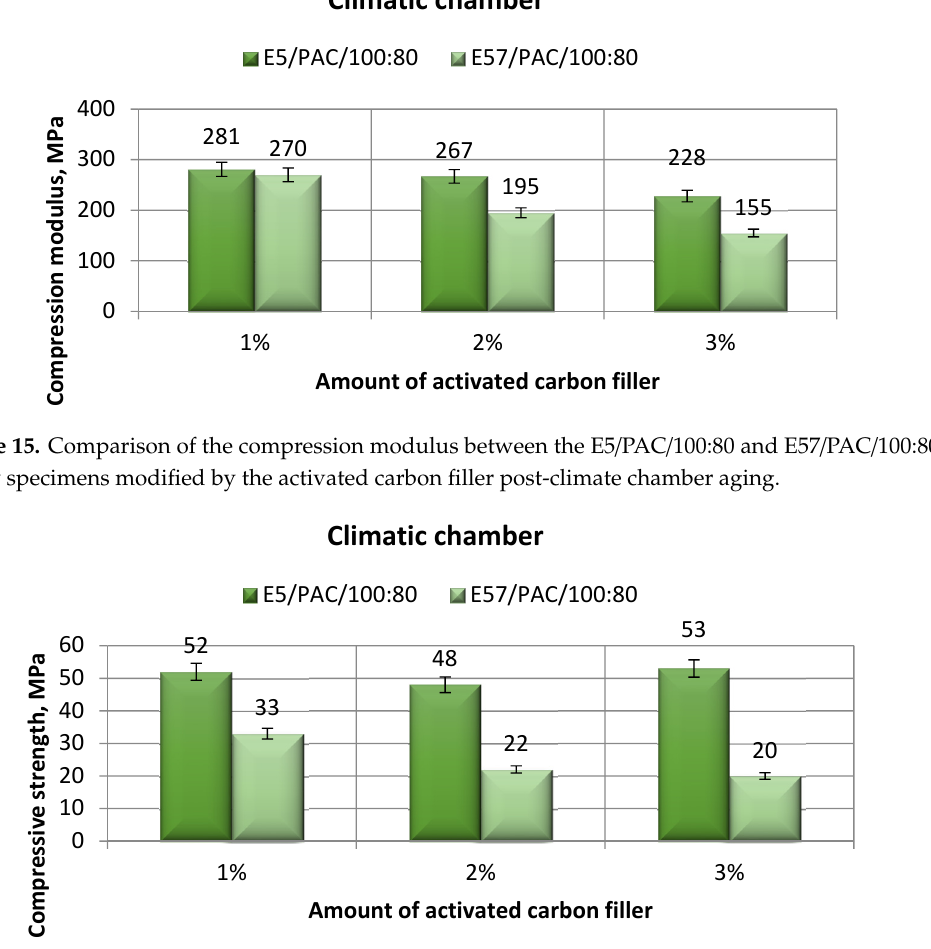
Figure 16. Comparison of the compressive strength between the E5/PAC/100:80 and E57/PAC/100:80 epoxy specimens modified by the activated carbon filler post-climate chamber aging.